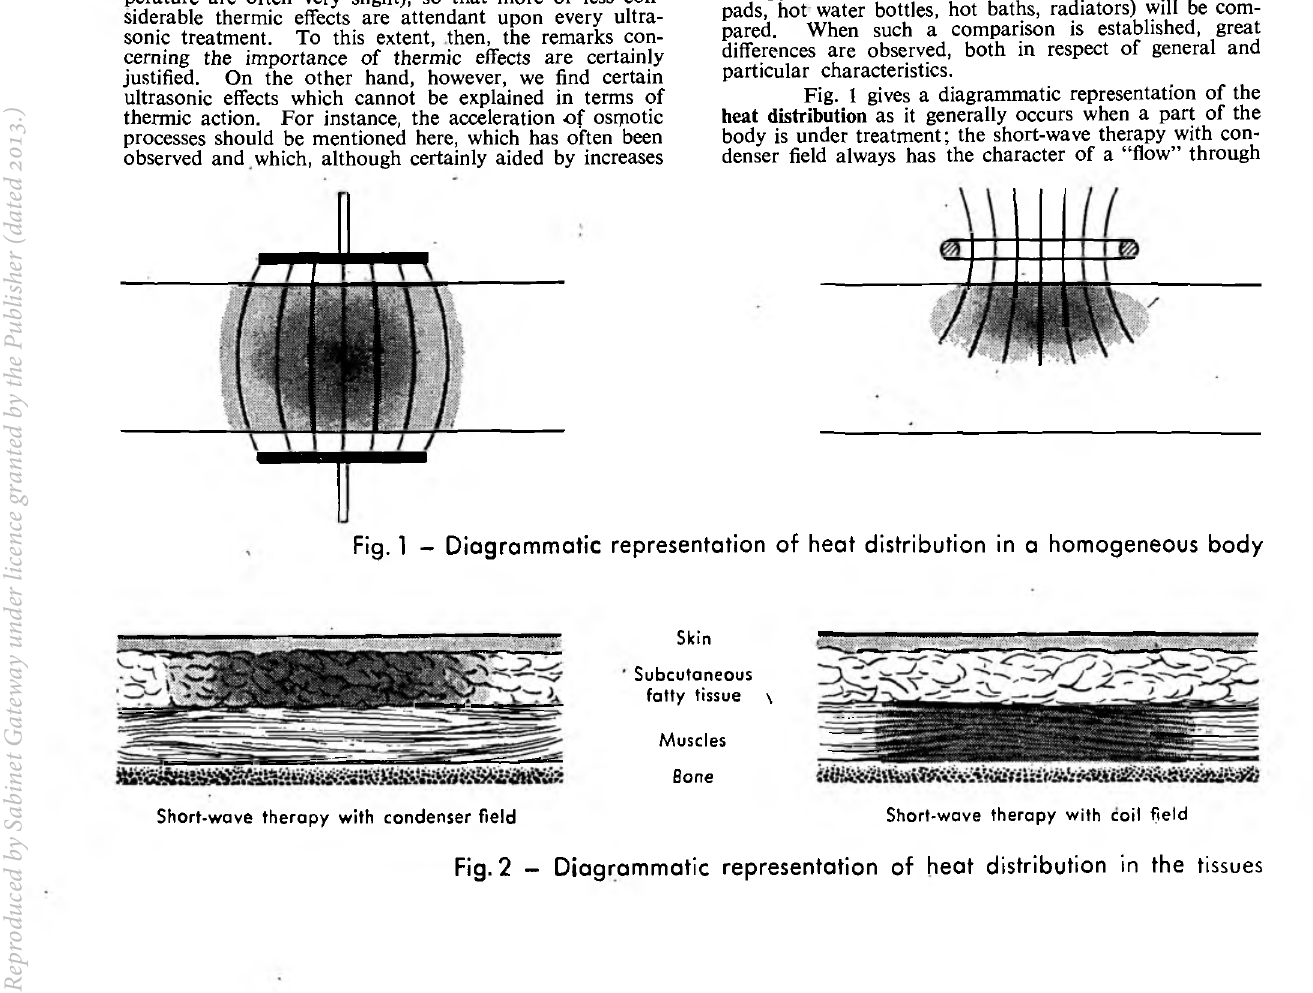
Fig. 2 - Diagrammatic representation of heat distribution in the